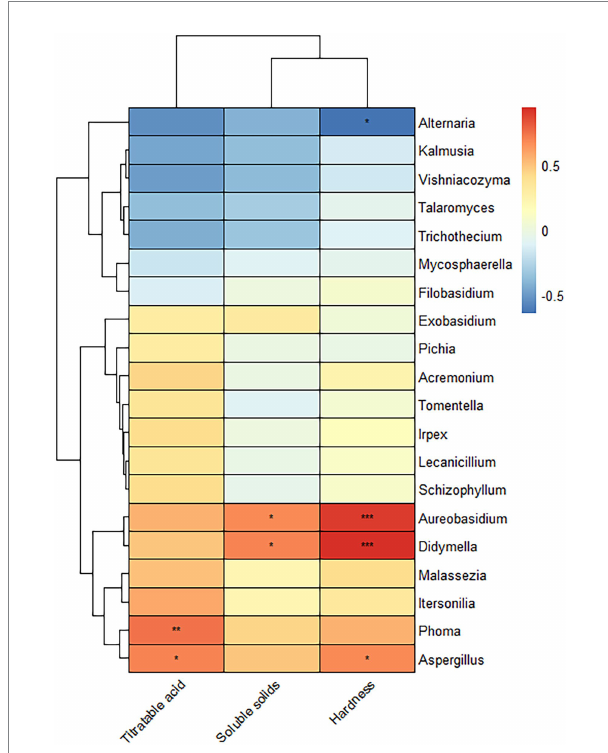
FIGURE 6 Correlation analysis of the fungi of Yuluxiang pear with fruit hardness, titratable acid, and soluble solids in different storage periods. Each column represents a bacterium. Blue is a negative correlation, and red is a positive correlation. * is a distinctive